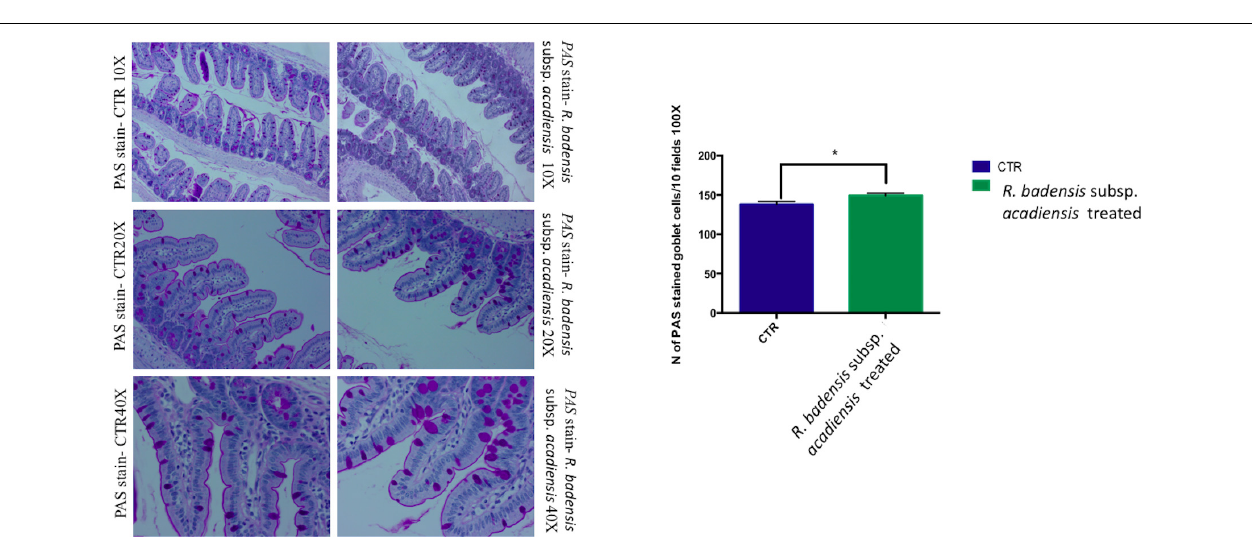
FIGURE 6 | Mean ± SEM of the number of goblet cells stained with PAS (Periodic Acid Schiff) in 10 fields of objective 100 × in the small intestine of mice fed 1% sucrose (CTR) or R. badensis subsp. acadiensis fed 10 8 CFU/mouse/day for 7 days. Significant difference exists if * p < 0.05- p = 0.035 Representative tissue photos are taken with objective 10 × , 20 × , and 40 × magnifications of the PAS-stained